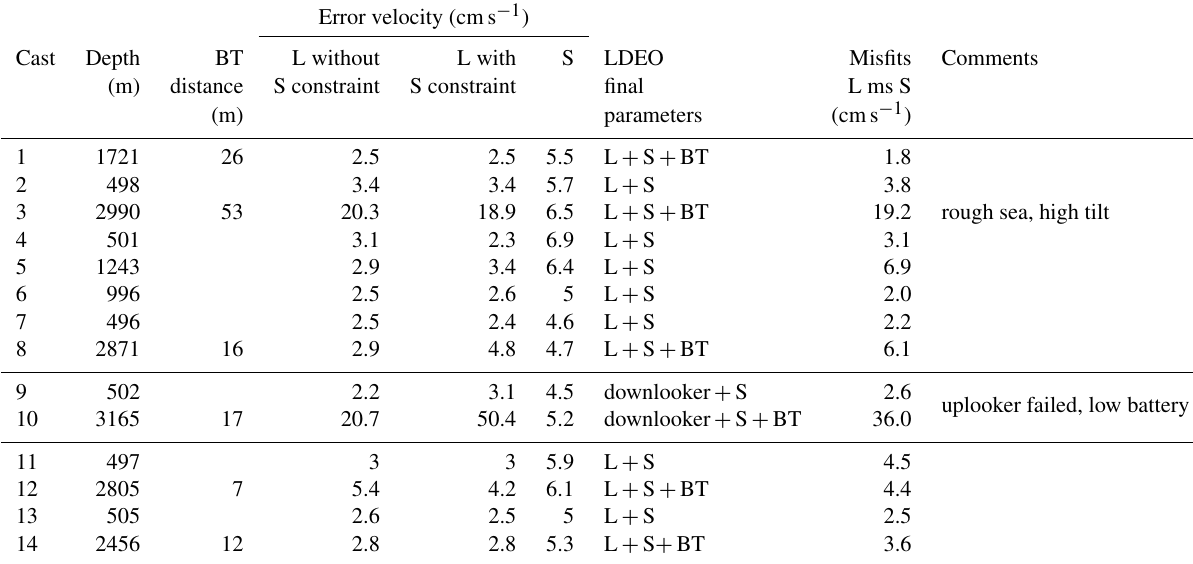
Table 3. Summary of ocean current profiles collected at the stations. Depth and bottom track (BT) distances, when available, are indicated. Error velocities were computed for three sets of profiles: LADCP (L) data only, SADCP (S) data only and L data processed under the constraint of S data. Final process parameters were chosen as a function that leads to the misfits between L (with final process parameters) and S